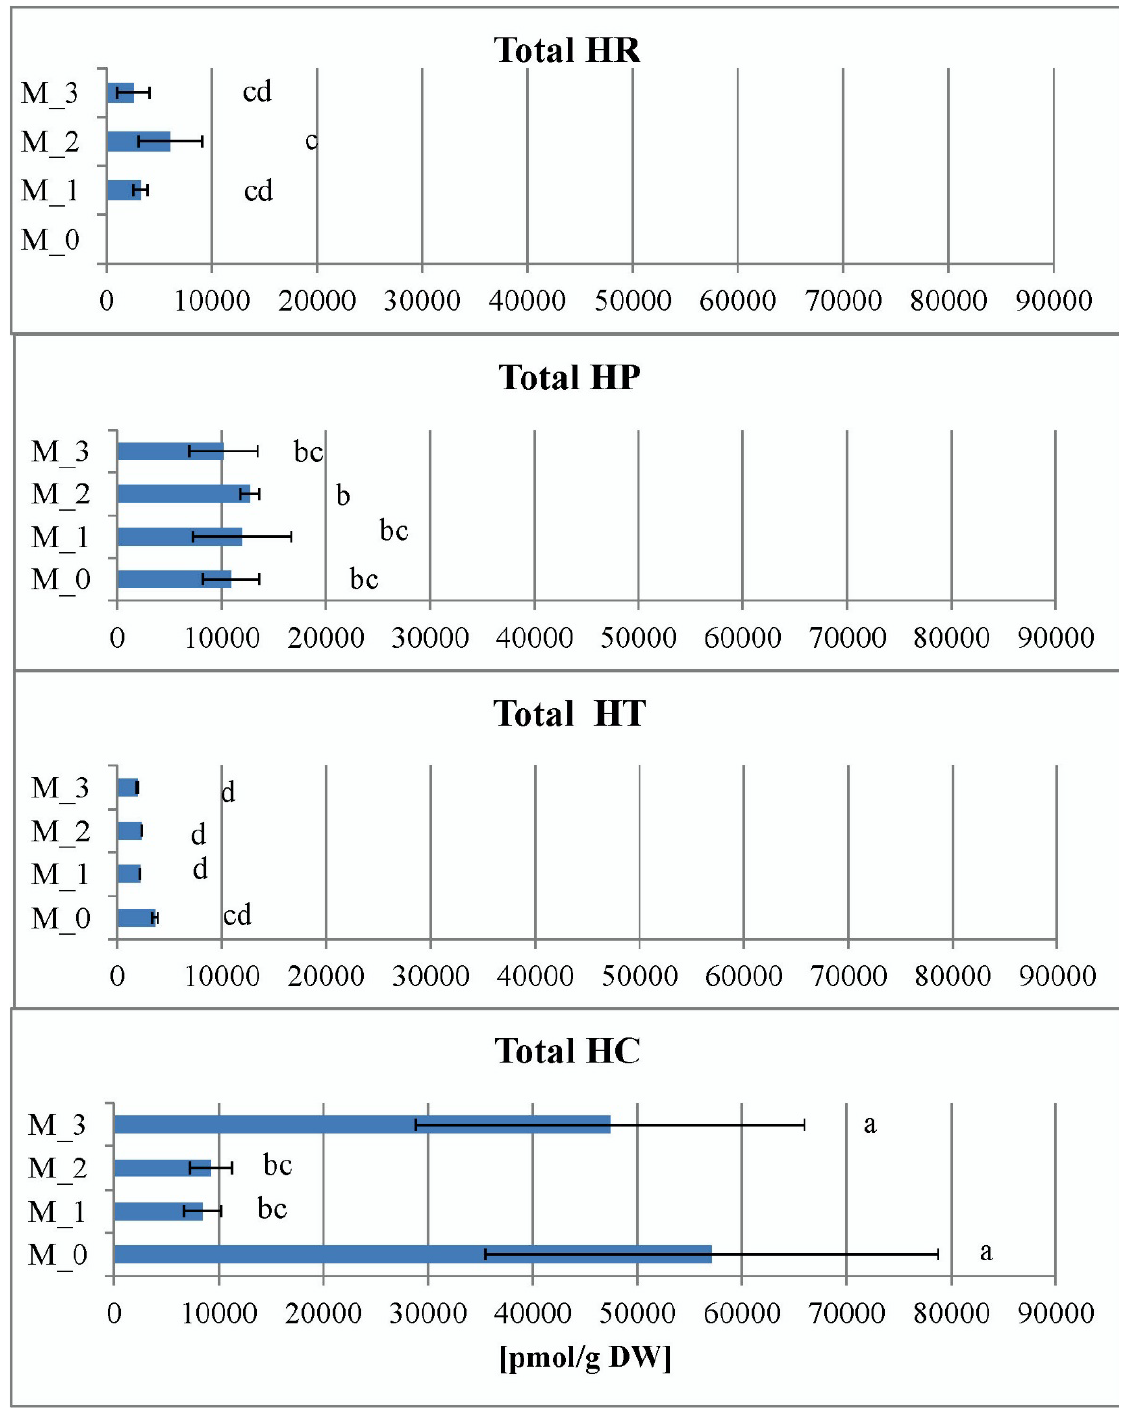
Figure 6. Representation of the total sum of the two abscisic acid (ABA) forms: ABA and its storage conjugate ABA–glucose ester (ABA–GE) in the four Hypericum species in M_0—PGR-free, M_1—0.2 mg/L BA, M_2—0.2 mg/L BA + 0.1 mg/L IBA and M_3—0.1 mg/L BA + 0.2 mg/L IBA supplemented media, HR— H. richeri Vill., HP— H. perforatum L., HT— H. tetrapterum Fries. and HC— H. calycinum. Same letters indicate statistically non-significant differences in mean values when comparing the parameter between all samples.